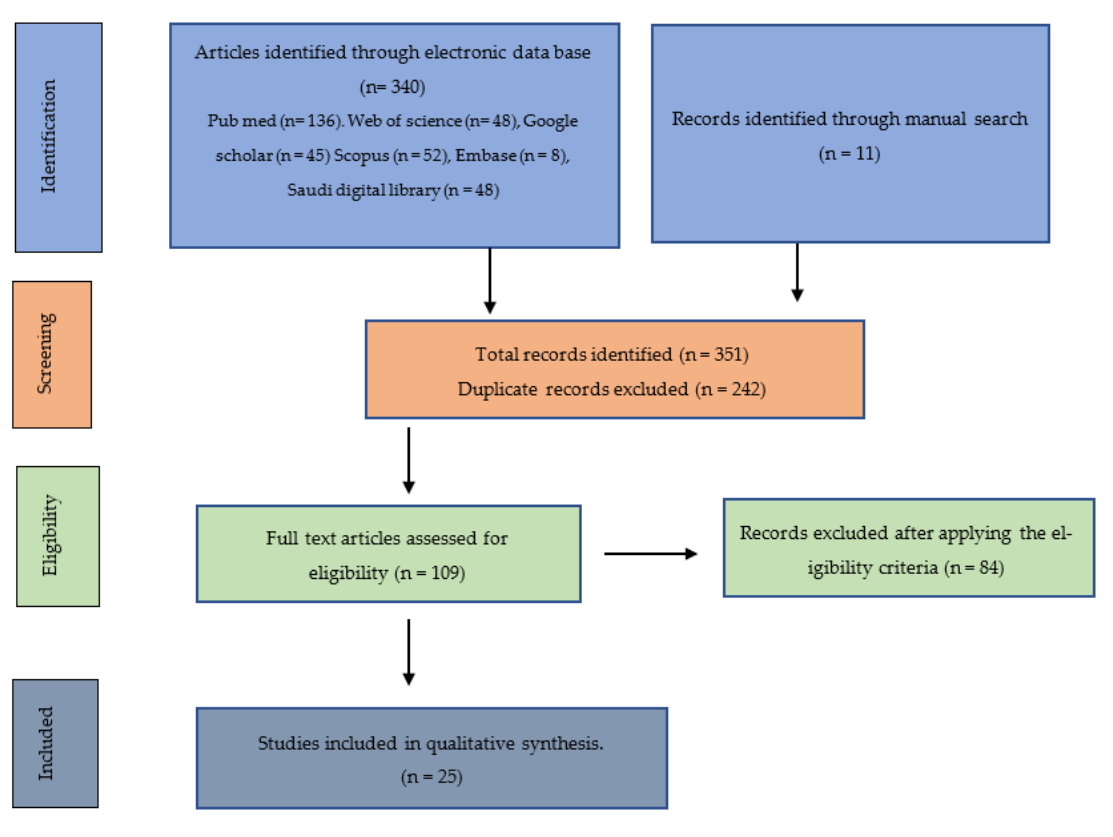
Figure 1. Flow chart for screening and selecting articles.